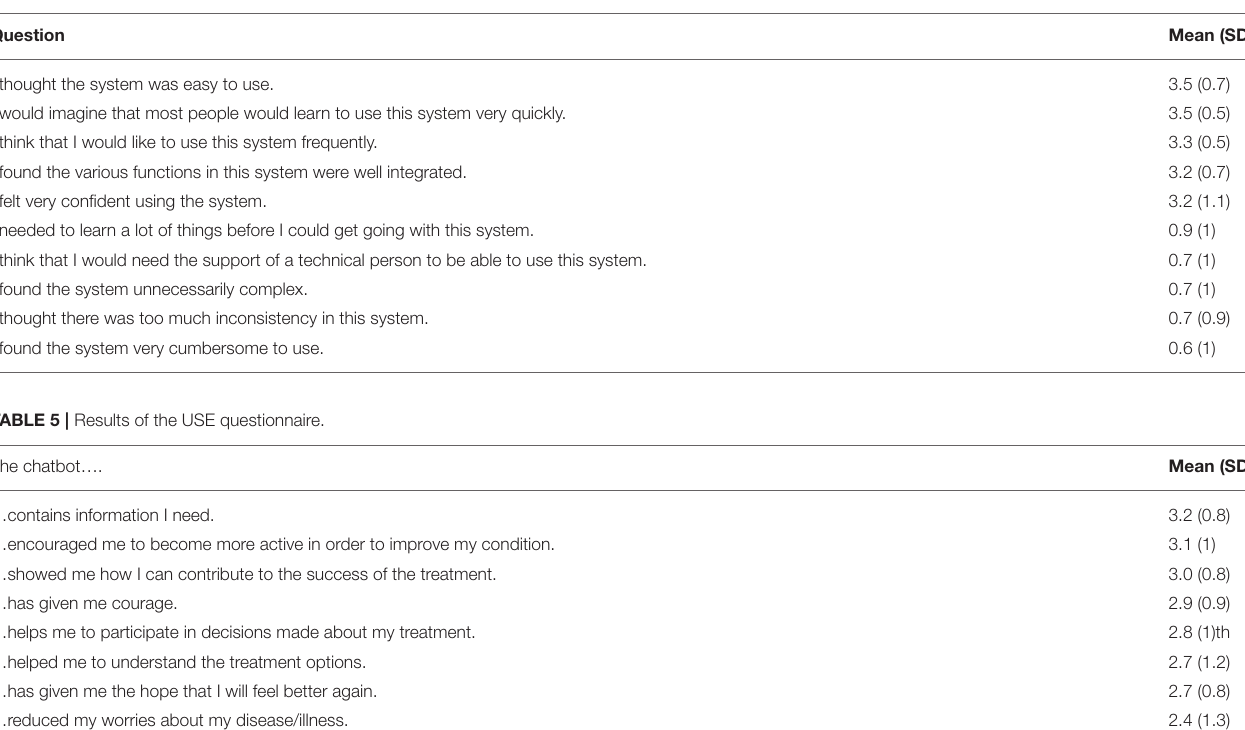
TABLE 4 | Results of the SUS questionnaire.